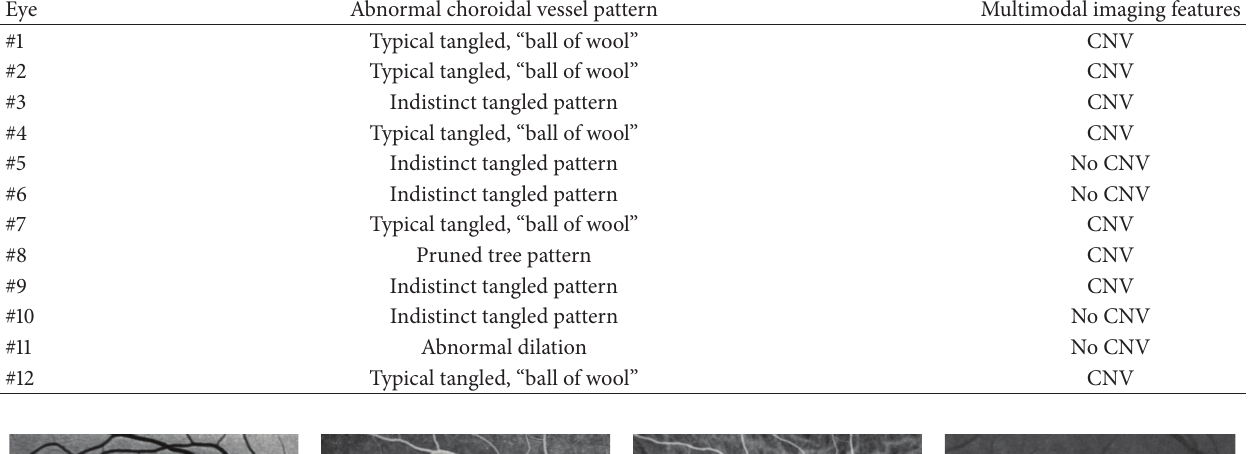
Table 3: Comparison between abnormal choroidal vessel at the choriocapillaris level and multimodal imaging evidence of choroidal neovascularization (CNV).